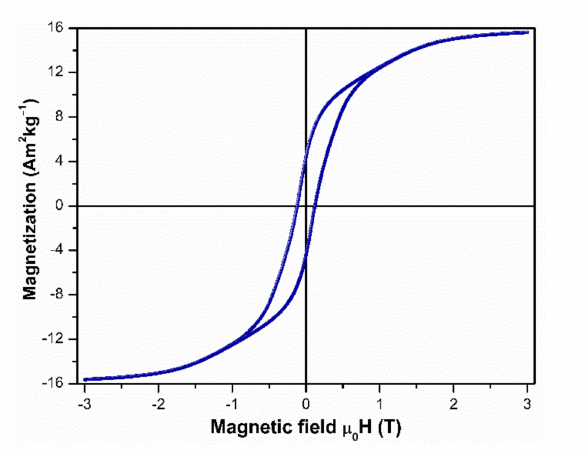
Figure 2. Hysteresis loop of the Nd 1.1 Fe 10 CoTi powder annealed at 1000 ◦ C for 10